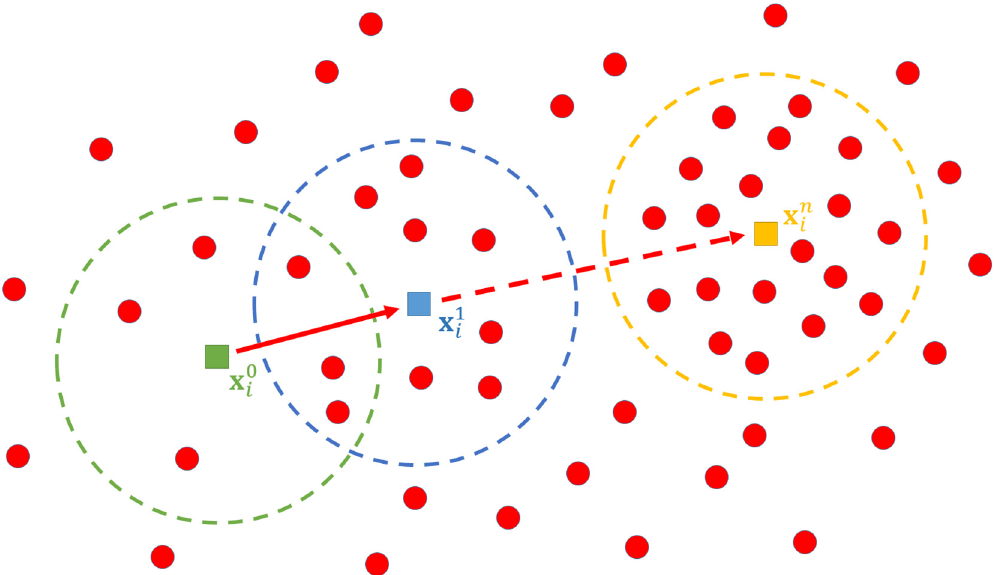
Fig 1. Mean shift algorithm procedure for a data point x i . The bold filled circles with arrows represent the iteration, while the pointed circles represent the window used in density estimation until the convergence is achieved at the n th